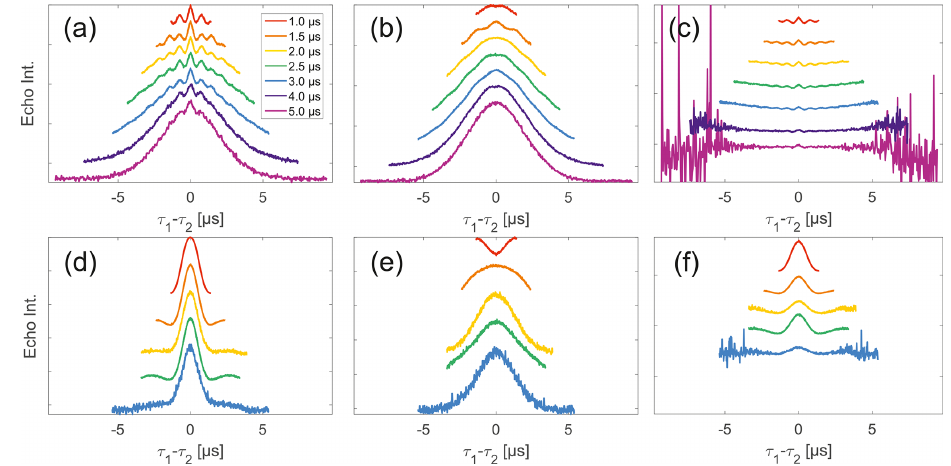
Figure 6. Analysis of data from SIFTER and SIDRE at various trace lengths on 50µM biradicals in OTP. Panels (a) – (c) show data of nitroxide biradical 3 ; (d) – (f) show data of trityl biradical 4 . The recorded traces of SIFTER (a, d) , and SIDRE (b, e) are shown. The remaining panels (c, f) show the result from division of SIFTER by the corresponding SIDRE traces. Traces in (c) and (f) are displayed in stack plots at arbitrary offset.